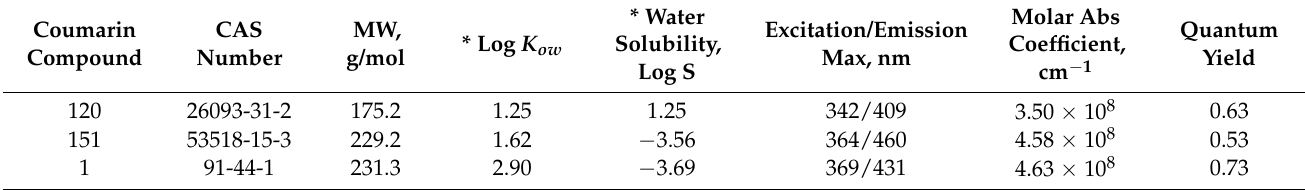
Table 1. Physical/chemical properties of coumarin 120, 151, and 1.